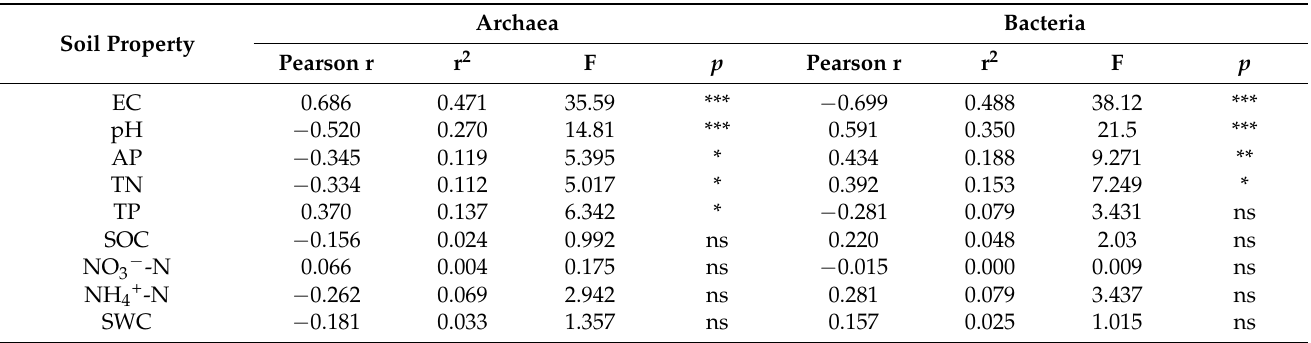
Figure 9. The redundancy analysis (RDA) illustrating the correlations between soil properties and microbial structure at the level of phyla. Table 2. Results of the linear regression analysis between the abundance of archaea and bacteria and soil properties.